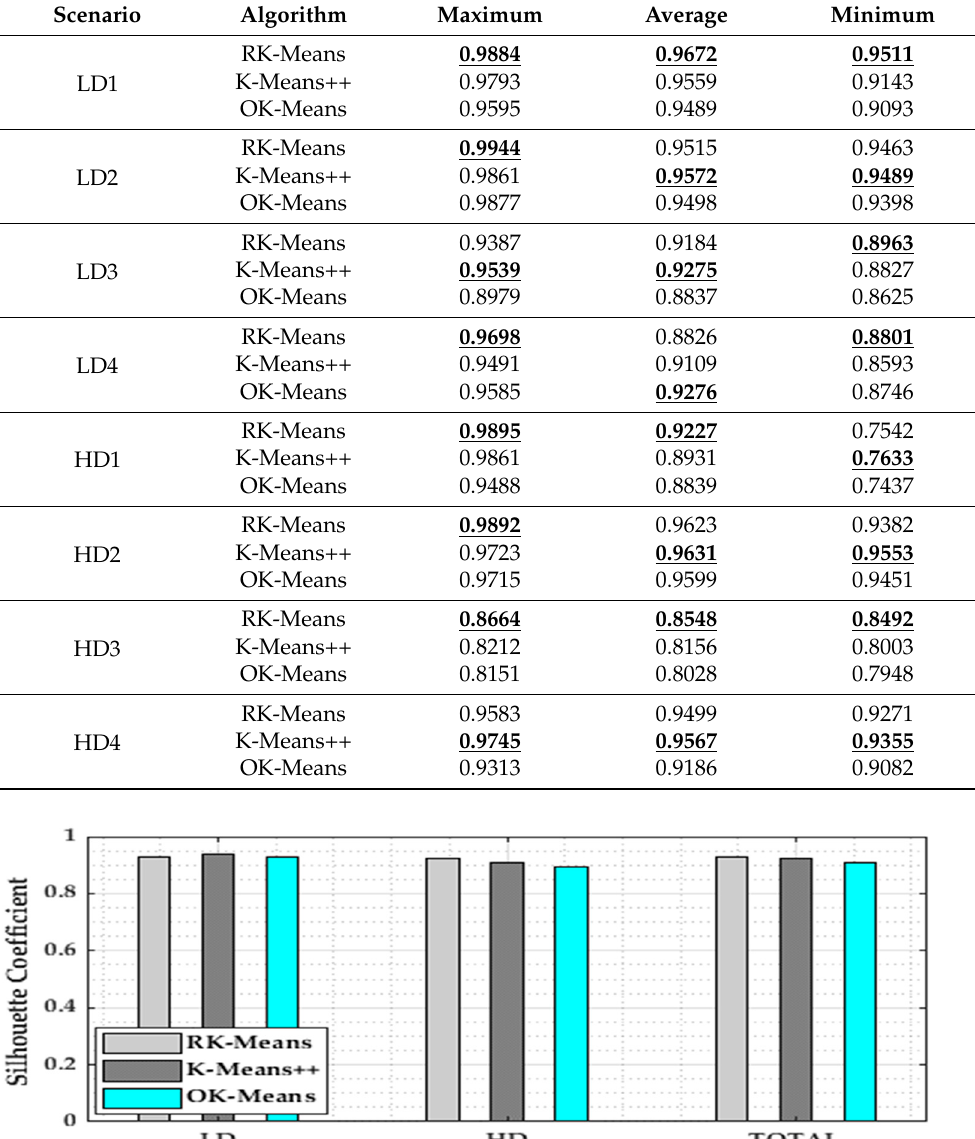
Table 8. SC numerical results.